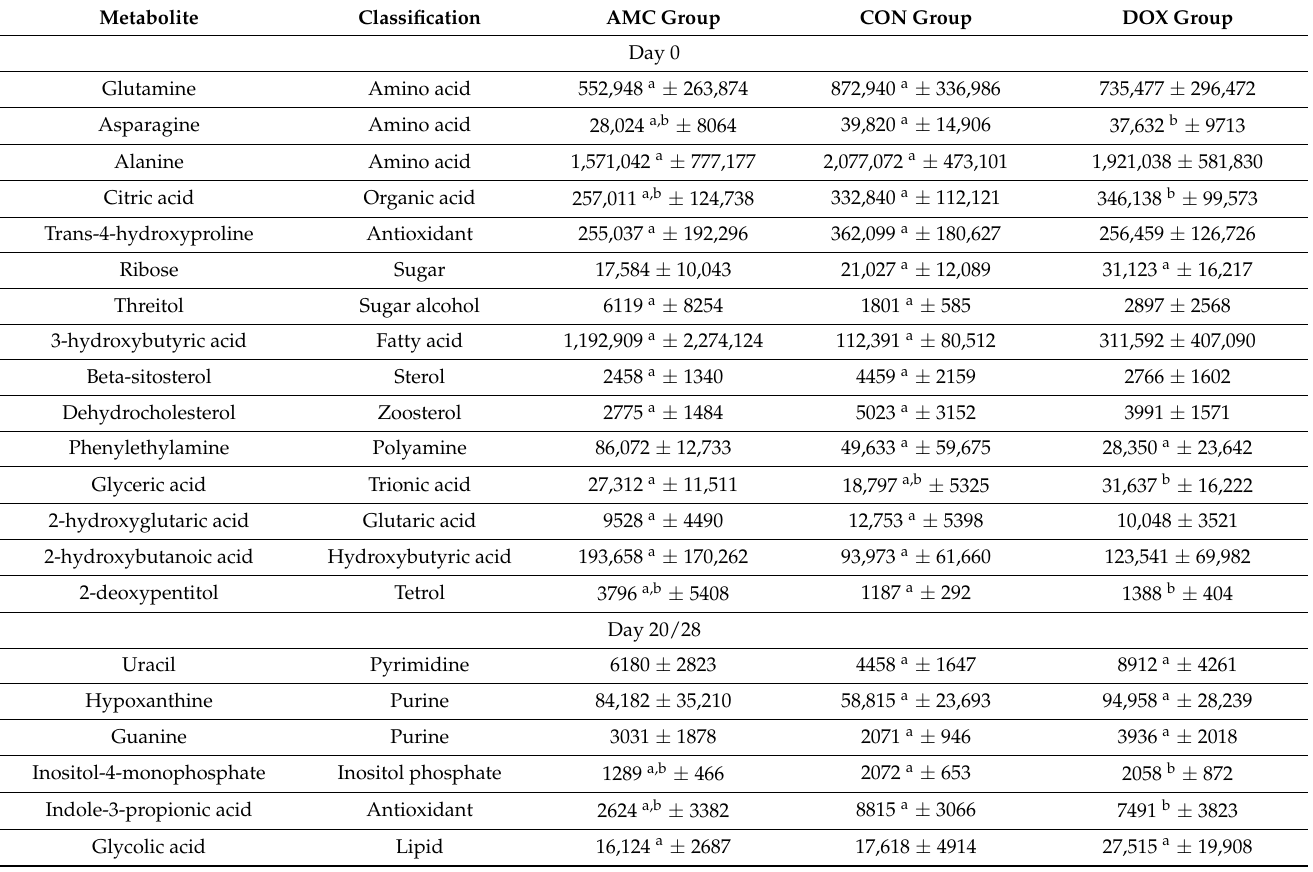
Table 1. Peak heights of serum metabolites that significantly differed among the groups at each